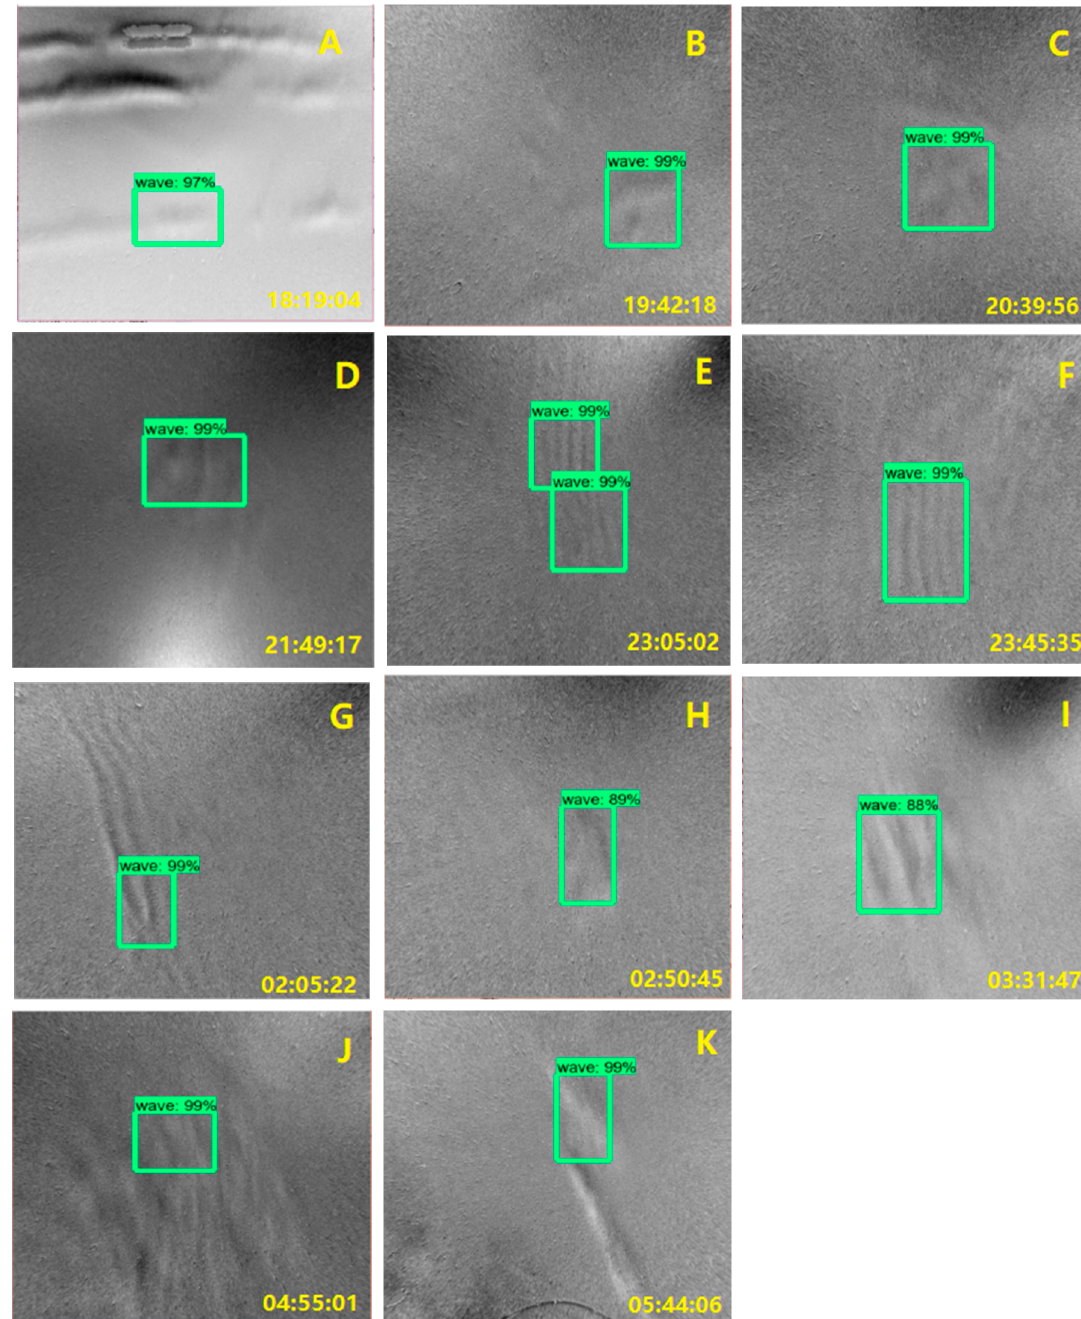
Figure 11. Detected representative wave-containing images. The detected wave structures are marked in the images with green rectangular and confidence values. The letters in the airglow images correspond to those in Figure 10a: ( E – G ) Gravity waves and ( A – D , H – K ) disturbances from mist or cloud. The shooting time (local time) is represented in the lower right corner.